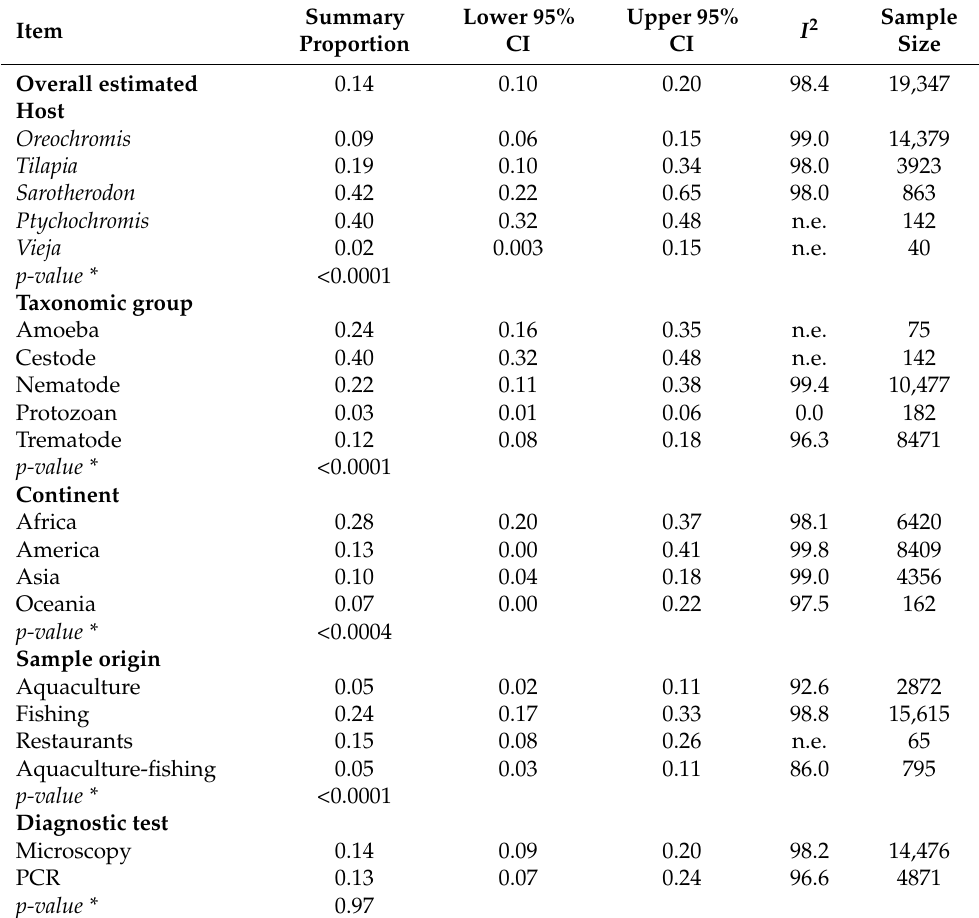
Table 3. Results of meta-analysis assessing the prevalence of parasitic infections with zoonotic potential in